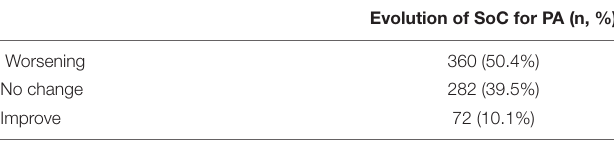
TABLE 2 | Evolution of the SoC for PA between the periods T0 and T1. Evolution of SoC for PA (n, %)